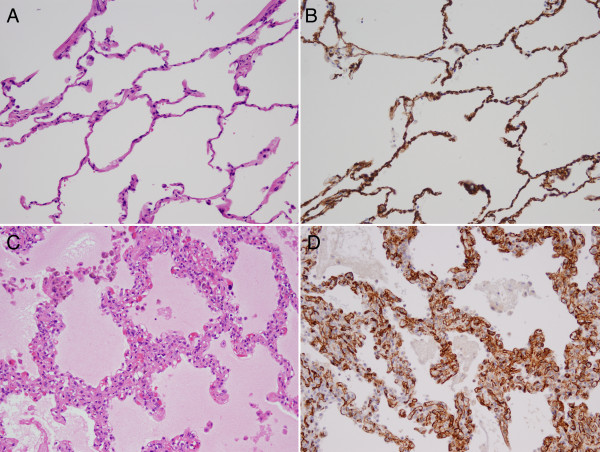
A case showing grade 1 alveolar septal capillary density (ASCD) (A and B) without any increase in endothelial cells in the alveolar septa (A: hematoxylin eosin stain; B: anti CD34 immunostain, ×200 original magnification). A case showing grade 2 ASCD (C and D) with a marked increase in endothelial cells (C: hematoxylin eosin stain; D: anti CD34 immunostain, ×200 original magnification).